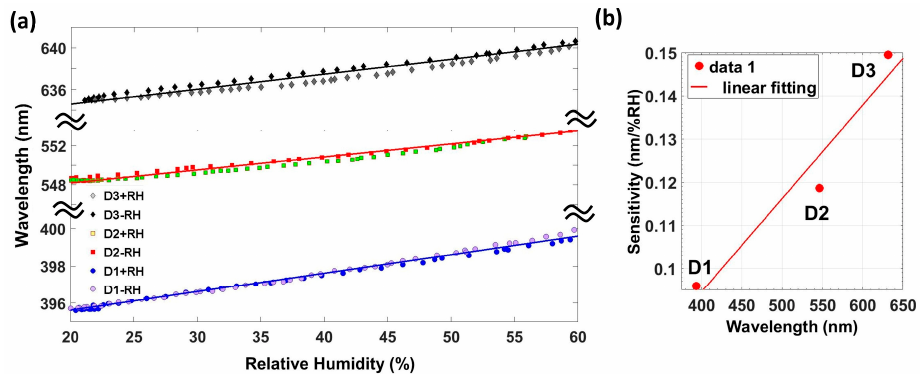
Figure 7. ( a ) Reflection wavelength as a function of the relative humidity for the three devices and ( b ) sensitivity as a function of the reflection wavelength for relative humidity ranging from 20%RH to 60%RH.